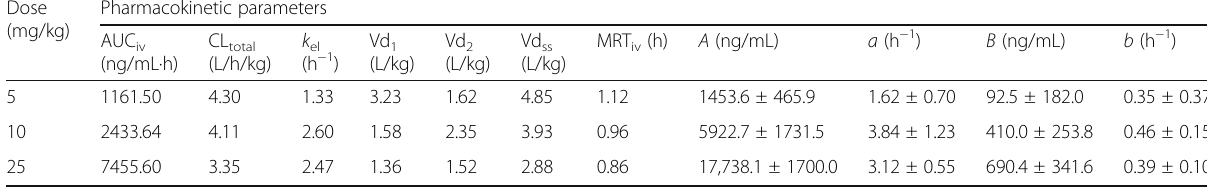
Table 1 Pharmacokinetic parameters of N-251 after intravenous administration in mice Dose Pharmacokinetic (mg/kg)